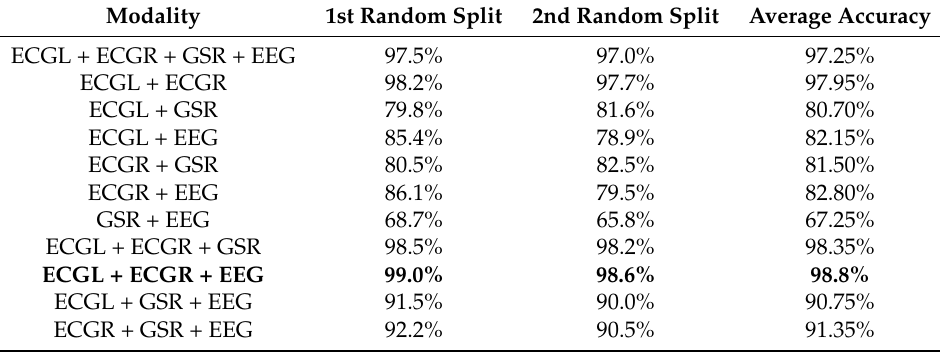
Table 4. AMIGOS results for majority voting (fusion of modalities). Highlighted row represents the best-performing combination of modalities.